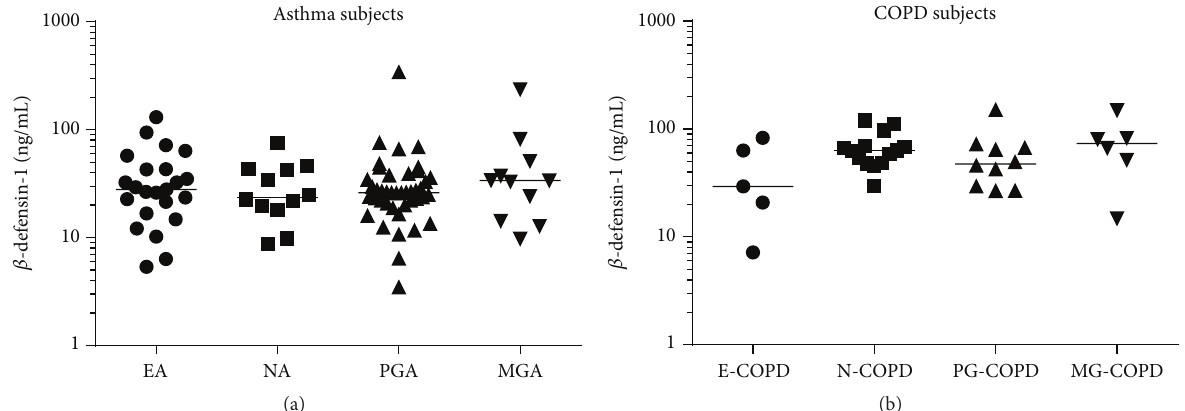
Figure 2: 𝛽 -defensin-1 in inflammatory phenotypes. The airway expression 𝛽 -defensin-1 protein is not different between inflammatory phenotypes of (a) asthma and (b) COPD. The bars represent the median of each group. EA = eosinophilic asthma; NA = neutrophilic asthma; PGA = paucigranulocytic asthma; MGA = mixed granulocytic asthma; E-COPD = eosinophilic COPD; N-COPD = neutrophilic COPD; PG-COPD = paucigranulocytic COPD; MG-COPD = mixed granulocytic COPD.